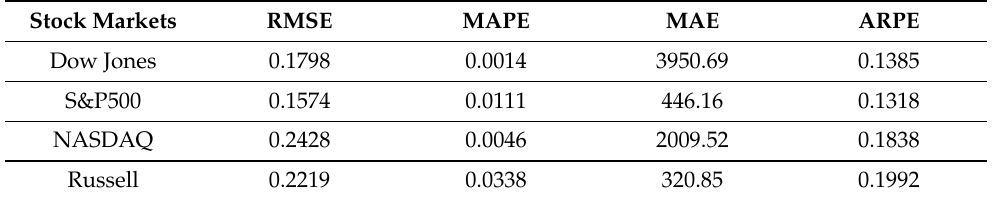
Table 9. Results from system of IG(a,b) OU model. The results reported are the best results from modeling a combination of the Dow Jones, the S&P500, the NASDAQ and the Russell. Stock Markets RMSE MAPE MAE ARPE Dow Jones